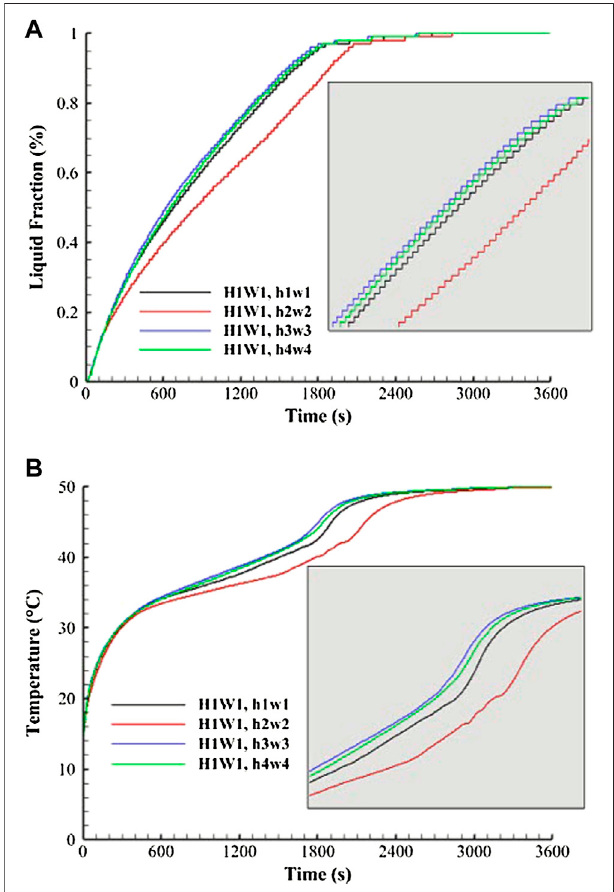
FIGURE 10 | (A) Heat storage rate; (B) melting time for various dimensions of the T-shaped fi n ’ s body [with the same size of the fi n ’ s head (H1W1)].